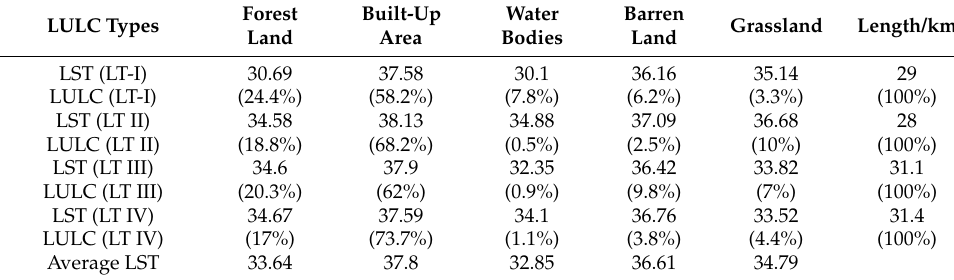
Figure 2. ( a ) LULC of the urban area of Beijing and ( b ) LST of the study area. Table 3. LULC (%) and average LST ( ◦ C) of transects. Table 4. The LST difference between LULC types.